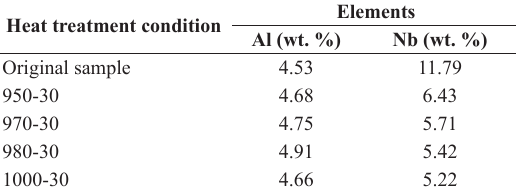
Table 2. The EDS results of β phase with different annealing temperatures and